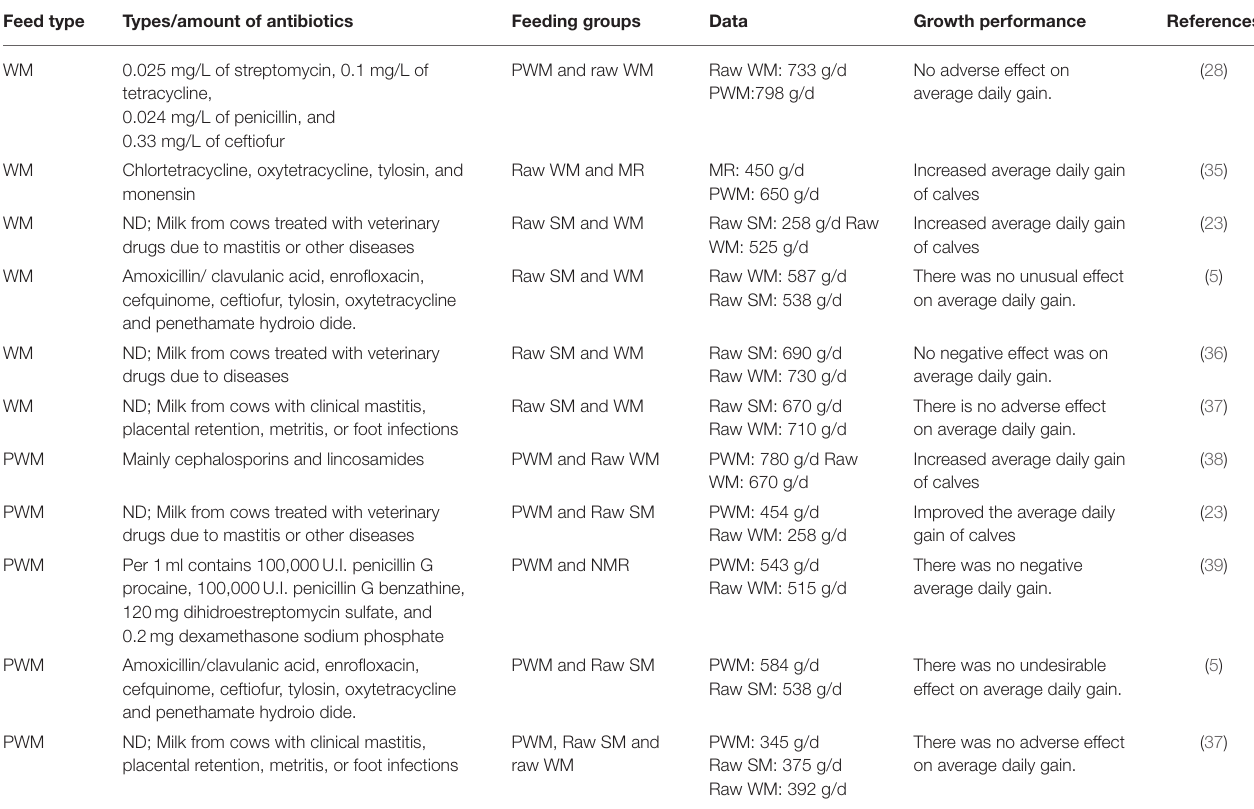
TABLE 1 | Effect of feeding raw WM and PWM on the growth performance of calves. Feed